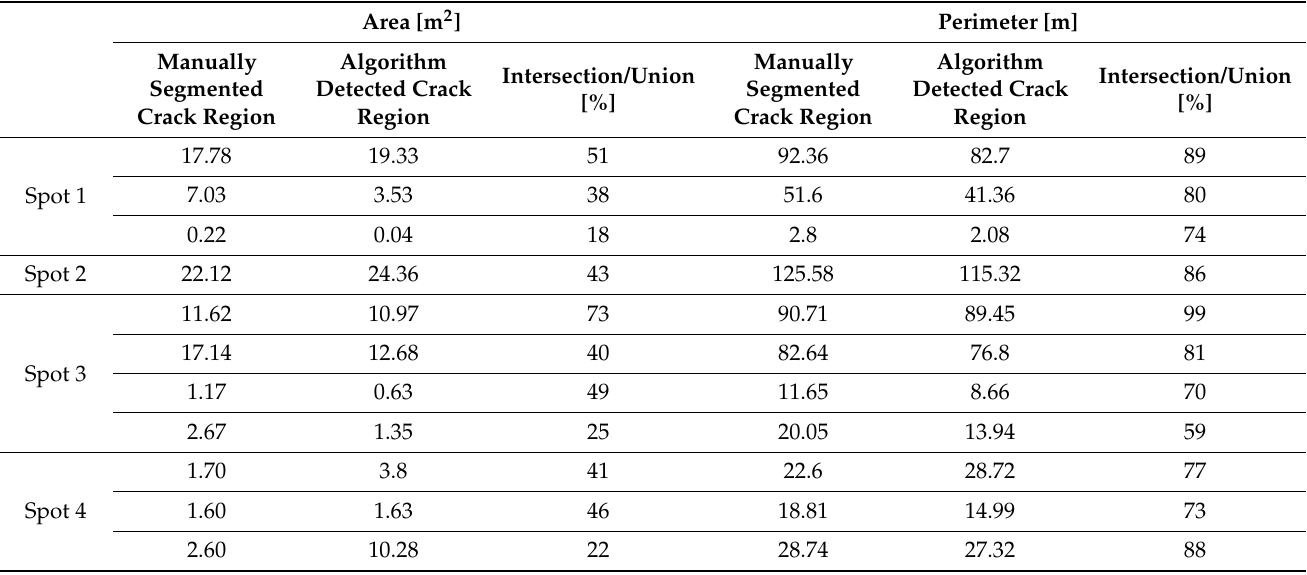
Table 2. Area and perimeter of crack clusters detected by the proposed algorithm compared to the cracked pavement regions manually segmented.